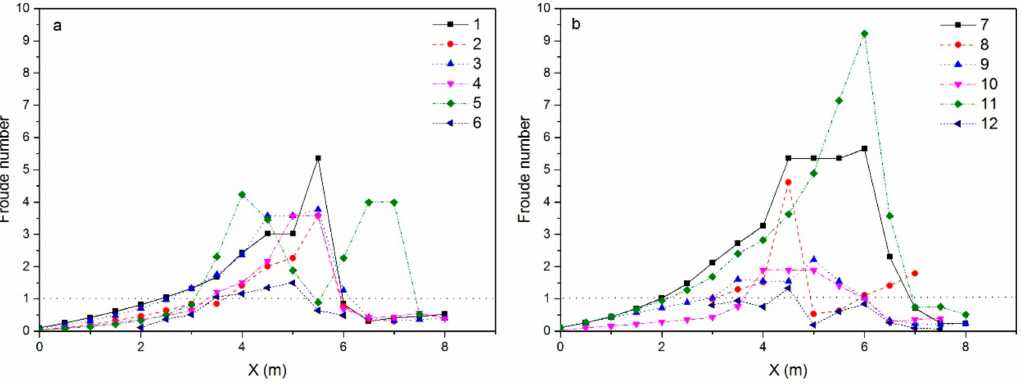
Figure 8. Froude number values obtained for all the experiments conducted. ( a ) shows the Froude number values for each test when the slope of the flume was 20 ◦ , ( b ) shows the Froude number values for each test when the slope of the flume was 25 ◦